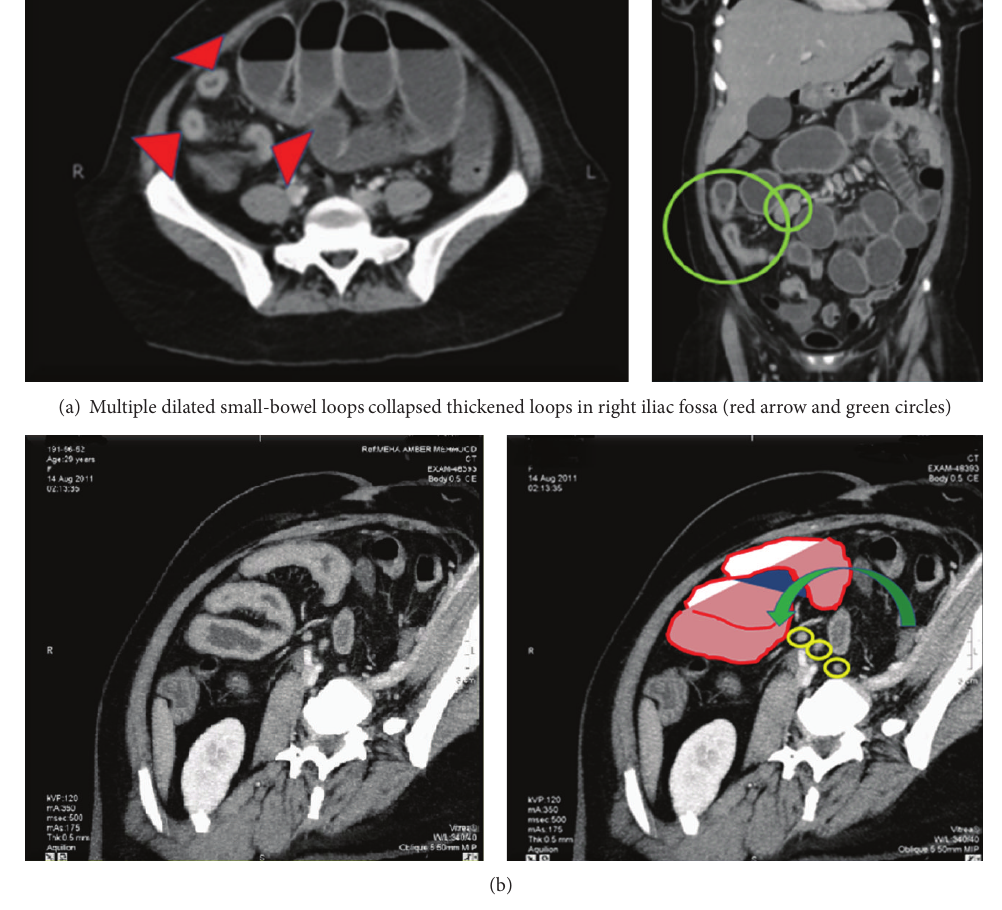
Figure 2: CT scan of 48-year-old female with acute abdominal pain. (a) Axial and coronal CT images obtained with intravenous contrast agents show dilated small-bowel loops (red arrow heads and green circles). (b) Oblique reformation shows dilated small-bowel loops with a transition point (green arrow) in the midabdomen. Multiple small mesenteric lymph nodes also visualized (yellow